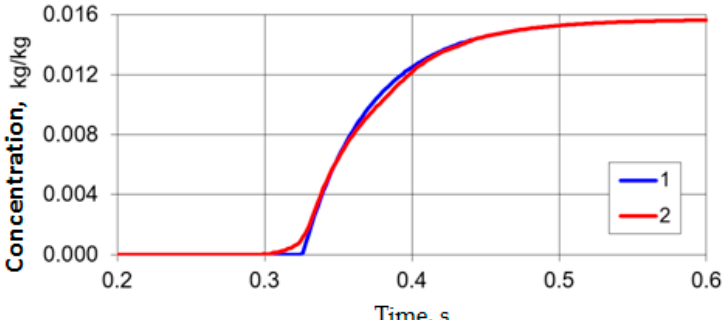
Figure 5. Comparison of the dynamics of changes in the concentration of water vapor: 1—calculation using the developed phenomenological model; 2—calculation using computational fluid dynamics (CFD) model.